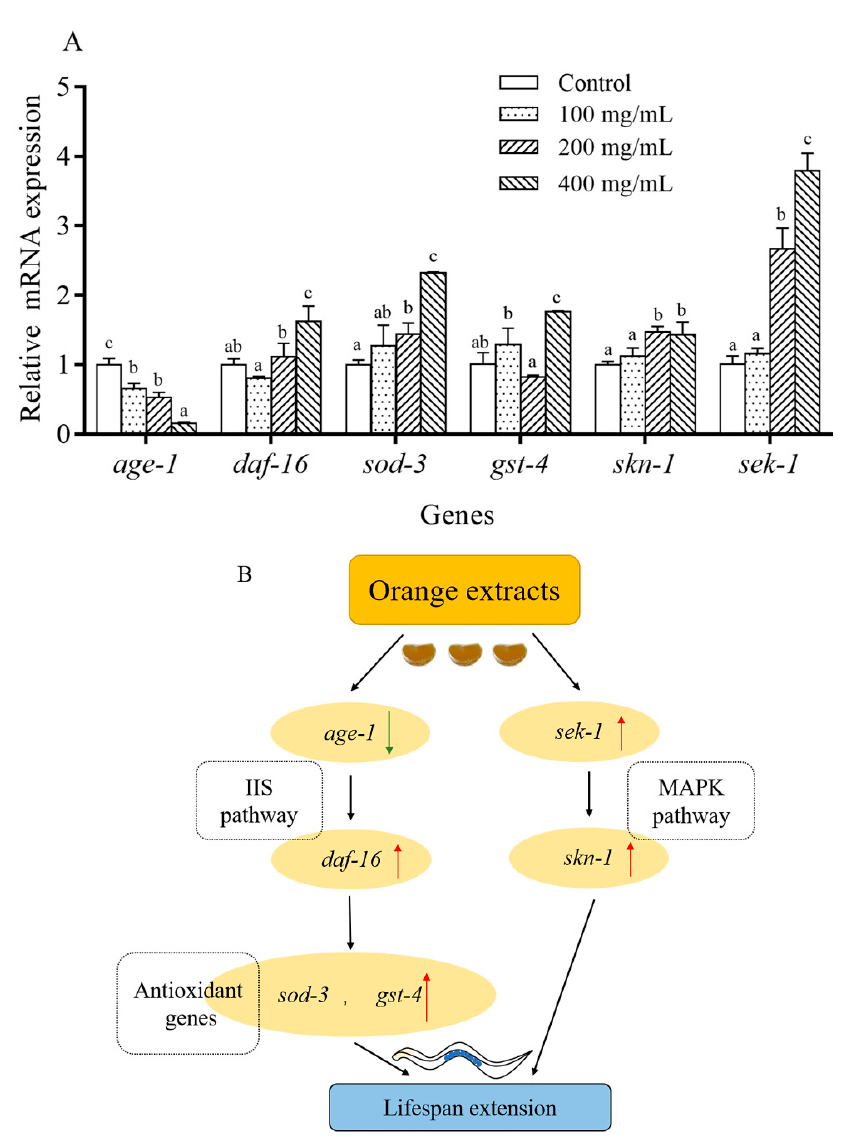
Figure 9. Effect of orange extracts on age-related gene expressions in C. elegans . ( A ) The mRNA expressions of age-related genes. Bars of the same gene with different letters indicate statistical significance ( p < 0.05, mean ± SD, n = 3). ( B ) Possible molecular mechanism of the anti-ageing effect of orange extracts.